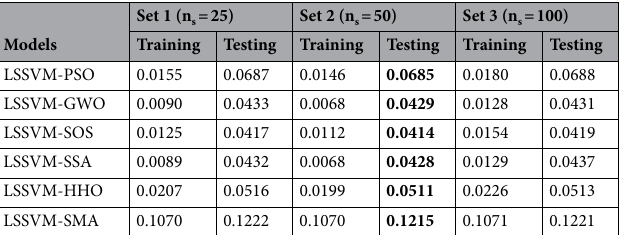
Table 2. RMSE value for different sets of constructed models. Significant values are in bold.